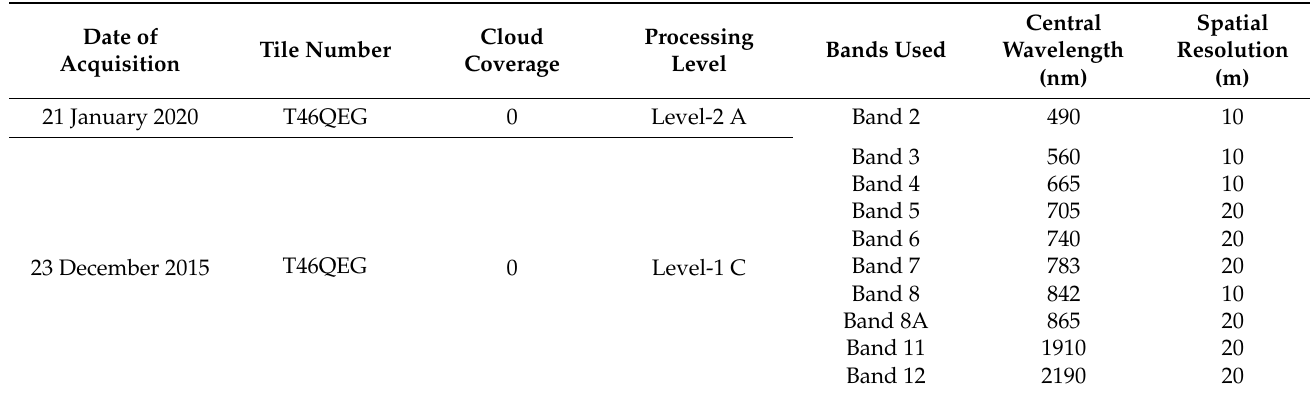
Table 2. Specification of Sentinel-2 products used in this